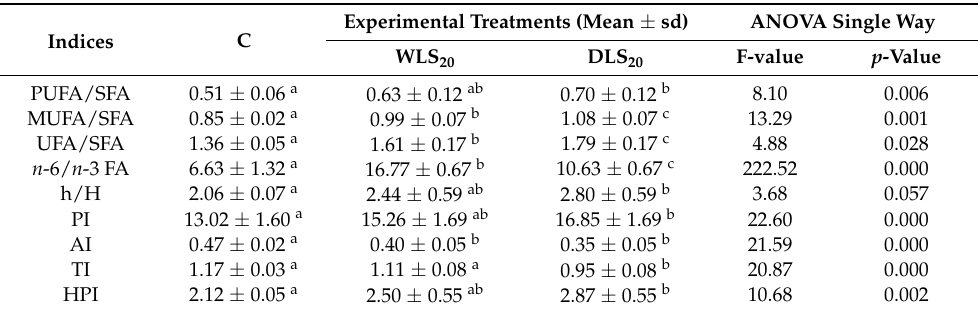
Table 8. Influence of dehulling white lupine seeds used in the laying quail diets on the lipid quality indices of egg